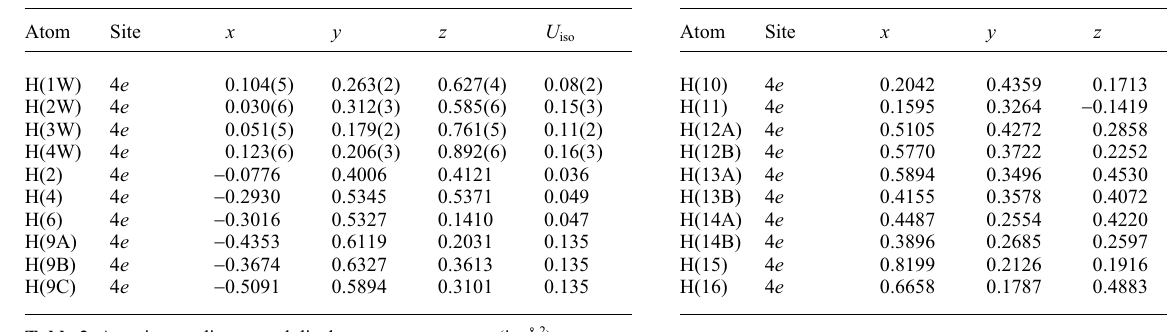
Table 2. Atomic coordinates and displacement parameters (in Å 2 ) . Table 2. continued